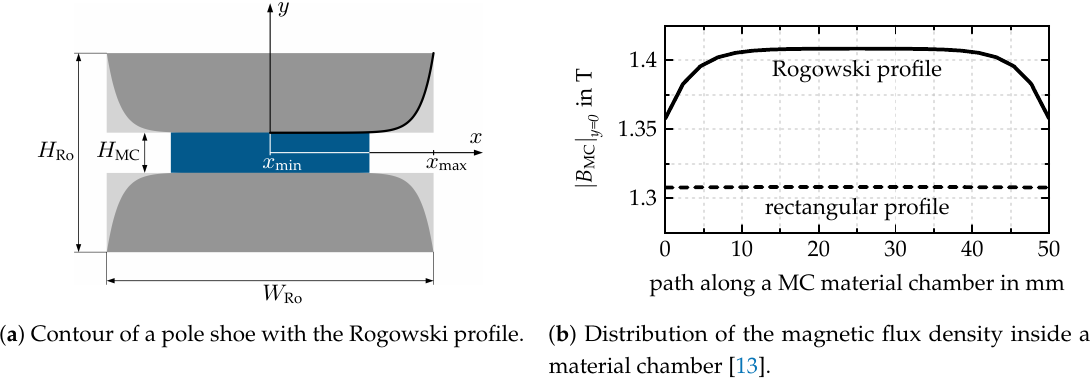
Figure 3. Comparison of the Rogowski profile to the rectangular pole shoe